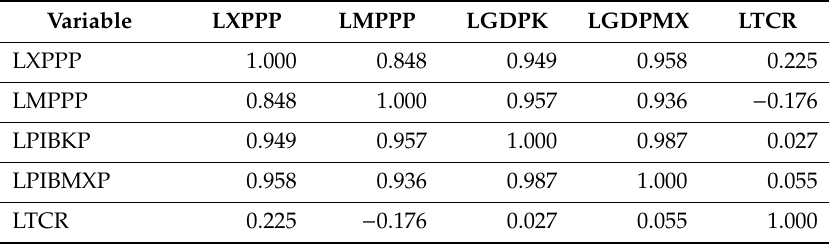
Table A3. Correlation Matrix of logarithmic transformations of data in Table